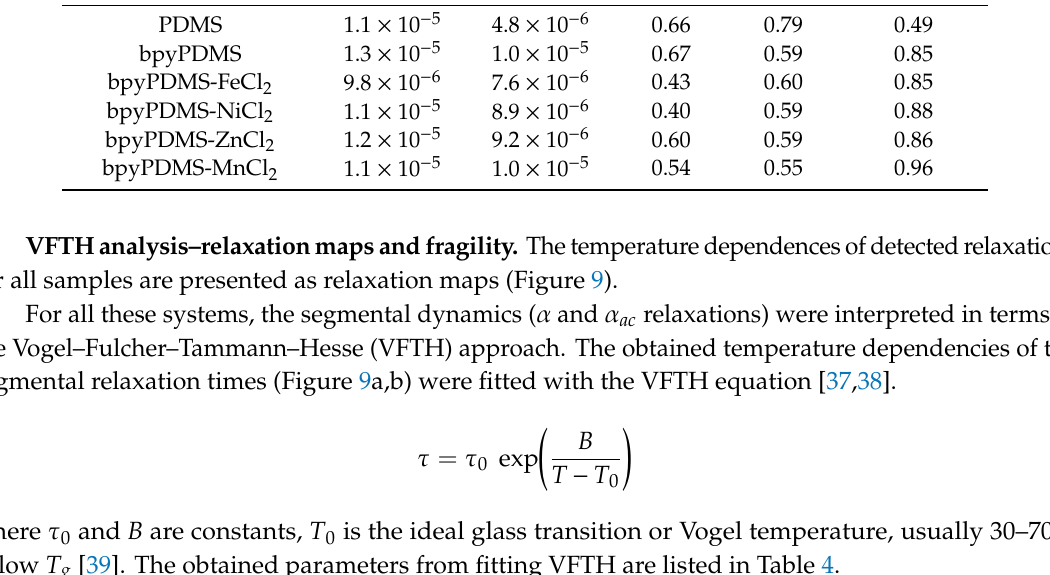
Figure 8. Normalized loss curves for PDMS, bpyPDMS and chosen metalloorganic complexes collected at 163 K. Symbols correspond to experimental points, whereas drawn lines are curves obtained from a WinFit analysis (Figure S7). Table 3. Havriliak–Negami (HN) parameters for α -relaxation processes in studied PDMS, bpyPDMS, and metalloorganic complexes obtained from the analysis of dielectric spectra at 163 K.